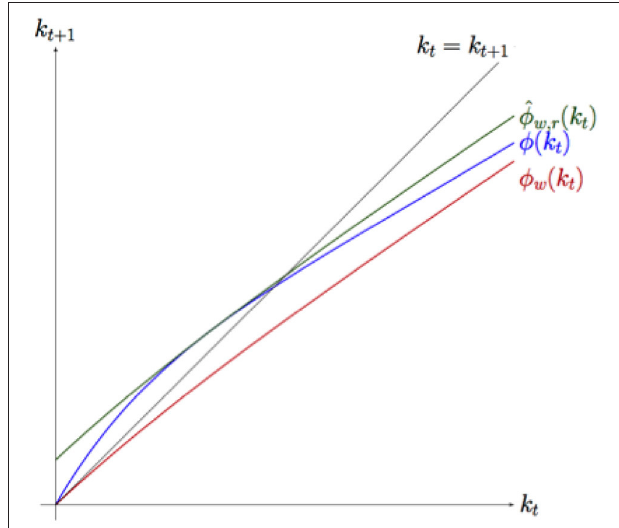
FIGURE 1 | Map φ (in blue) and its bounds ˆ φ w , r ( k t ) and φ w ( k t